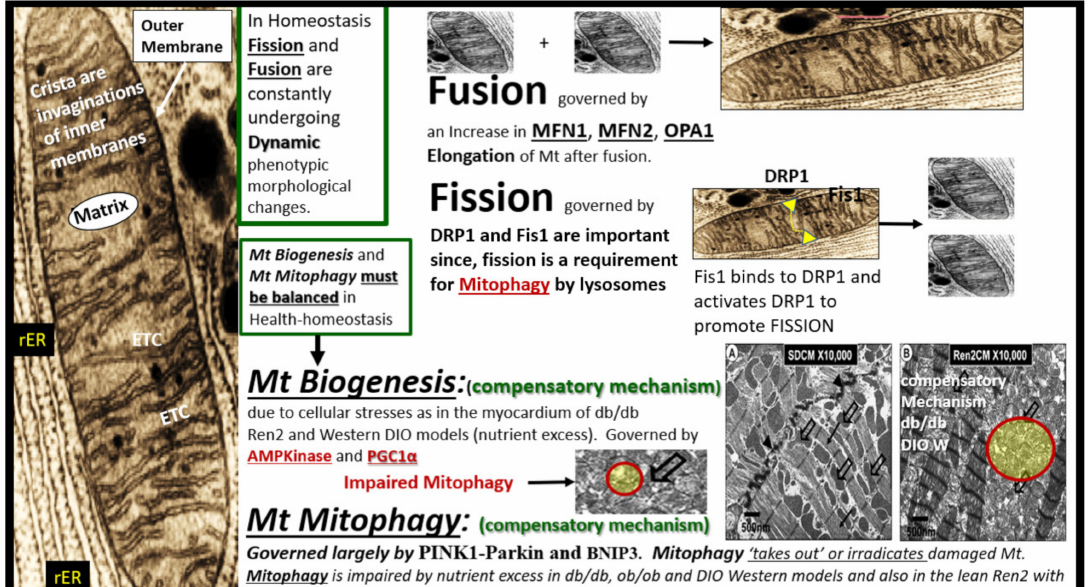
Figure 5. Possible morphological remodeling mechanisms as described by a brief overview of mitochondrial (Mt) fusion, fission, biogenesis, and mitophagy. Mt are known to consist of four distinct compartments: the outer membrane (arrow), the intermembrane space (not shown), the inner membrane of the crista, and the matrix (far left-hand side of this image). In general Mt consist of various shapes and sizes ranging from 0.5–3 µ m with an outer membrane of ~7 nm and an inner membrane of ~5 nm. In living cells mitochondria are constantly in motion and moving, changing their shapes and sizes, and are observed to fuse (fusion) or split (fission). The adaptive processes of Mt fusion, fission, biogenesis, and mitophagy are illustrated in this figure with a brief description of the governing mechanisms and images. As one begins to better understand these complex mechanisms that are in play in various diseases the better, we become at understanding Mt remodeling in their response to injury to various metabolic stressors. AMP Kinase = adenosine monophosphate-activated protein kinase; Ang II = angiotensin II; BNIP3 = Bcl-2 (B-cell lymphoma 2)/adenovirus E1B 19-kDa- interacting protein 3; DIO = diet-induced obesity; DRP1 = Dynamin-related protein 1; ETC = electron transport chain; Mt = mitochondria; MFN1 and 2 = mitofusin 1 and 2; OPA1 = optic atrophy gene 1; Parkin = PTEN (Phosphatase and tensin homolog)—induced kinase 1; PINK = Parkinson’s disease-associated gene; PTC = proximal tubule cell; PGC1 α = peroxisome proliferator-activated receptor-gamma coactivator; W = Western diet-induced obesity; rER = rough endoplasmic